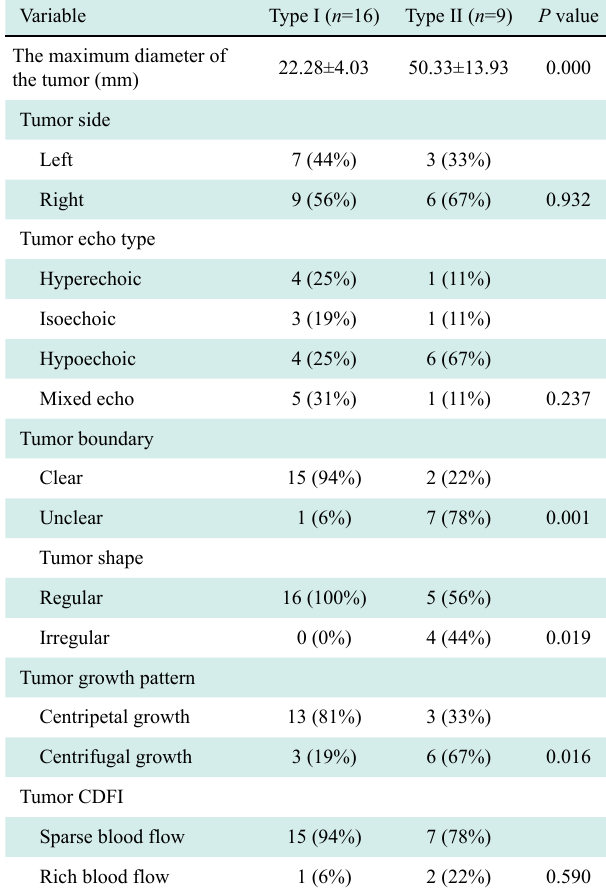
Table 2 Comparison of the characteristics of types I and II PRCC on conventional ultrasound